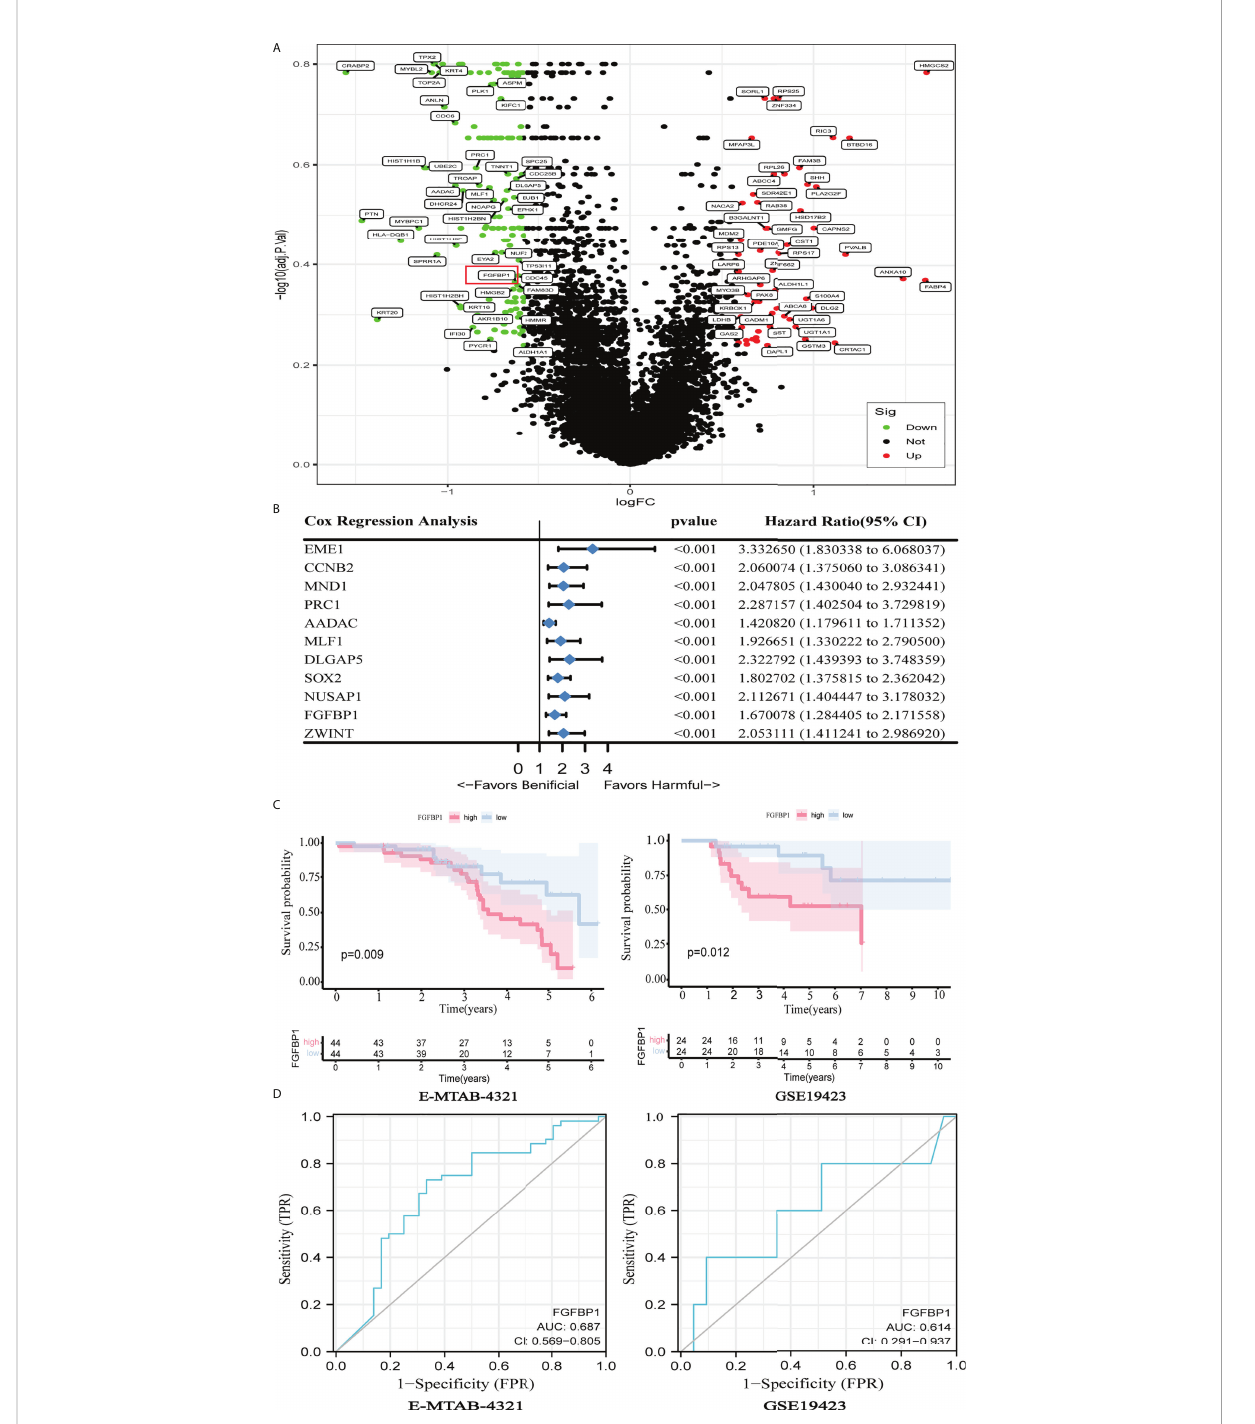
FIGURE 1 Elevated FGFBP1 may be associated with poor BCG response. (A) Volcano plot showed DEGs between BCG responders and failures in the E- MTAB-4321dataset, with FGFBP1 signi fi cantly upregulated in failures (marked in red). (B) Univariate Cox analysis revealed 11 genes that were associated with the prognosis of BCa in the E-MTAB-4321 dataset. (C) K-M survival curves indicated that elevated FGFBP1 expression was signi fi cantly associated with poor prognosis in the E-MTAB-4321 and GSE19423 datasets. (D) The ROC curves suggested that FGFBP1 has the ability to predict response to BCG